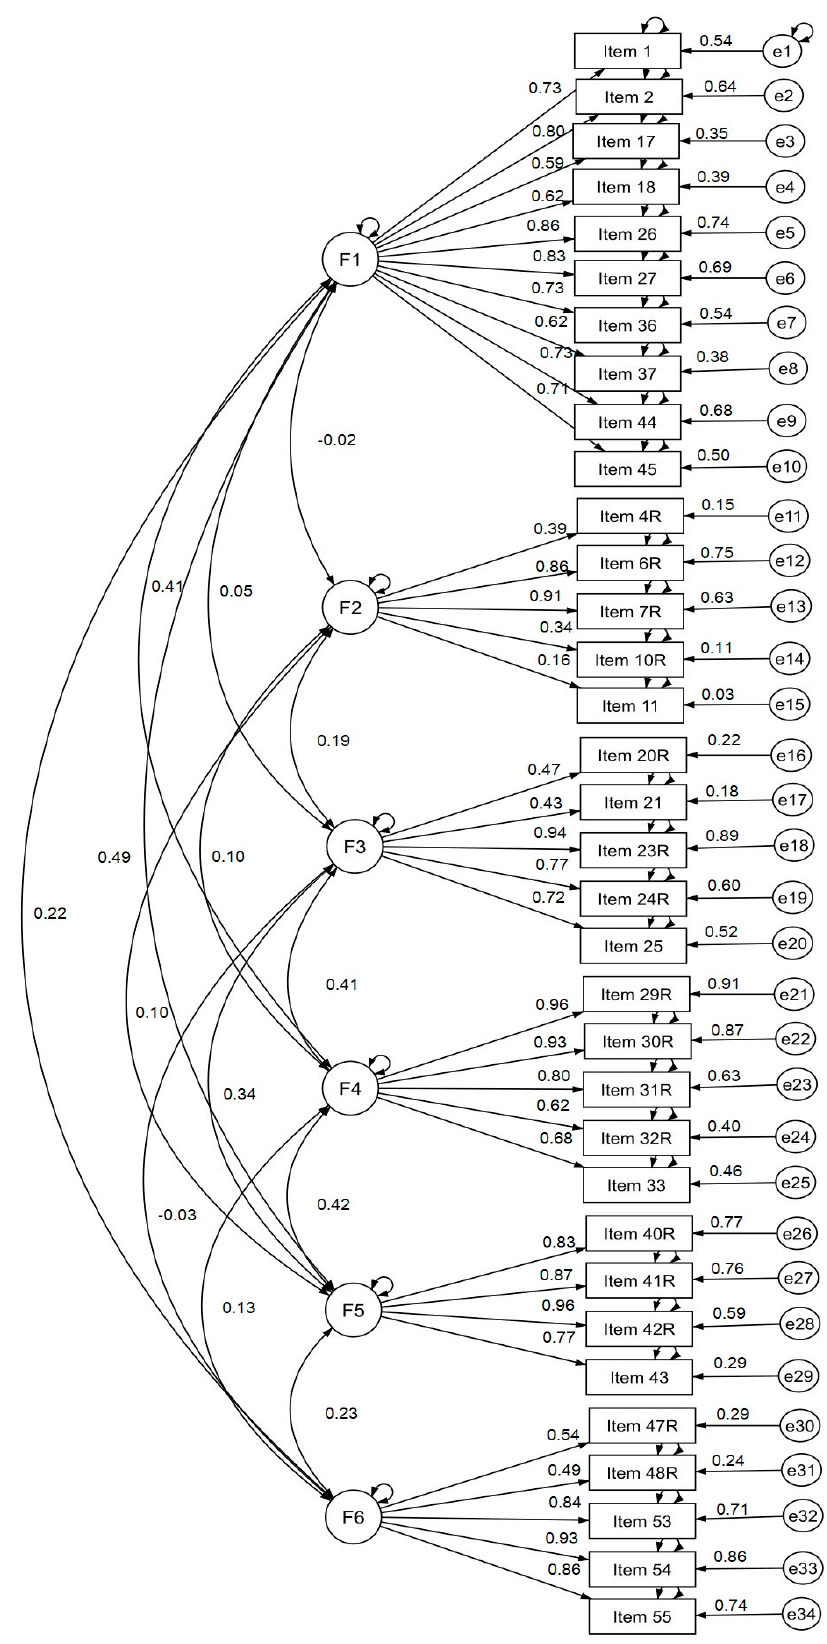
Figure 2. A posteriori six-factor model of the survey.